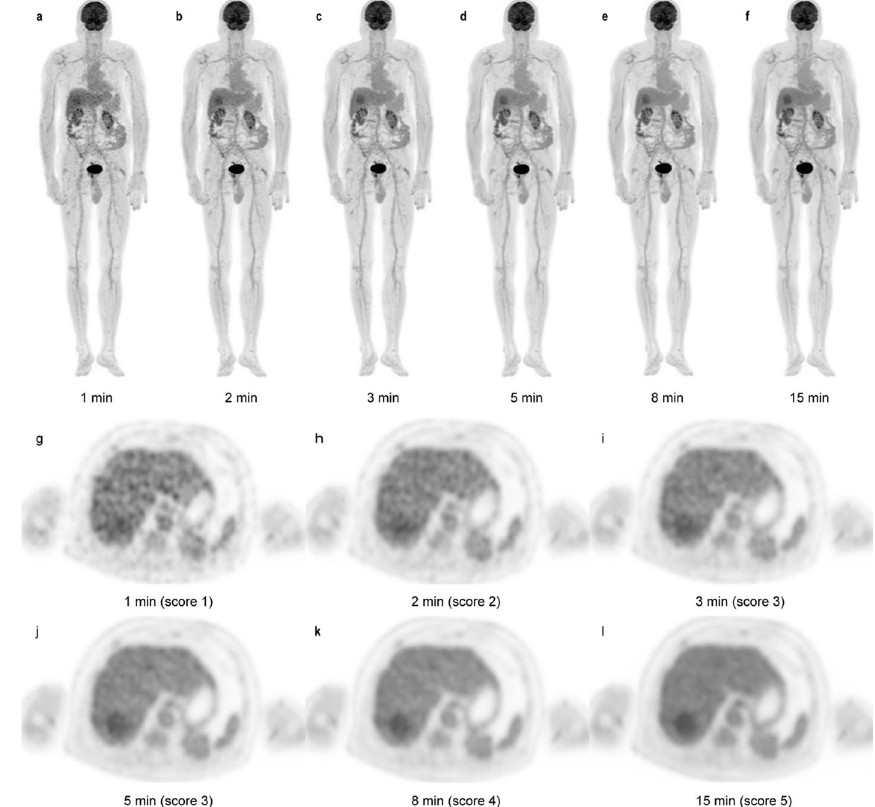
Fig. 1 An example of qualitative analysis. An FDG-avid lesion with a diameter of 50.0 mm in the right posterior lobe of the liver is seen on G1 to G15 images with maximum intensity projection (MIP) ( a – f ) and the axial view ( g – l ). The axial view G1, G2, G3, G5, G8, and G15 images were given scores of 1, 2, 3, 3, 4, and 5,